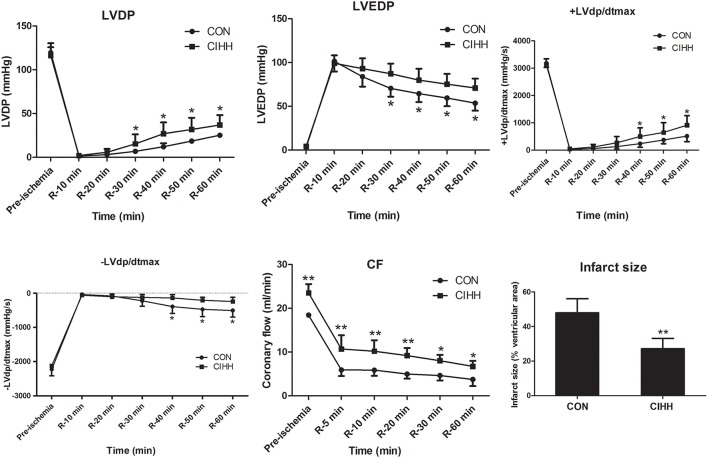
Effect of chronic intermittent hypobaric hypoxia on cardiac function and infarct size in isolated rat hearts subjected to 30 min of global ischemia followed by 60 min of reperfusion. LVDP, Left ventricular developing pressure; LVEDP, left ventricular end-diastolic pressure; +LVdp/dtmax, maximum rate of rise of left ventricular developed pressure; −LVdp/dtmax, maximum rate of decline of left ventricular developed pressure; CF, coronary flow. Data are expressed as the mean ± SD (n = 6 for each group). *P < 0.05, **P < 0.01 vs. corresponding CON group.